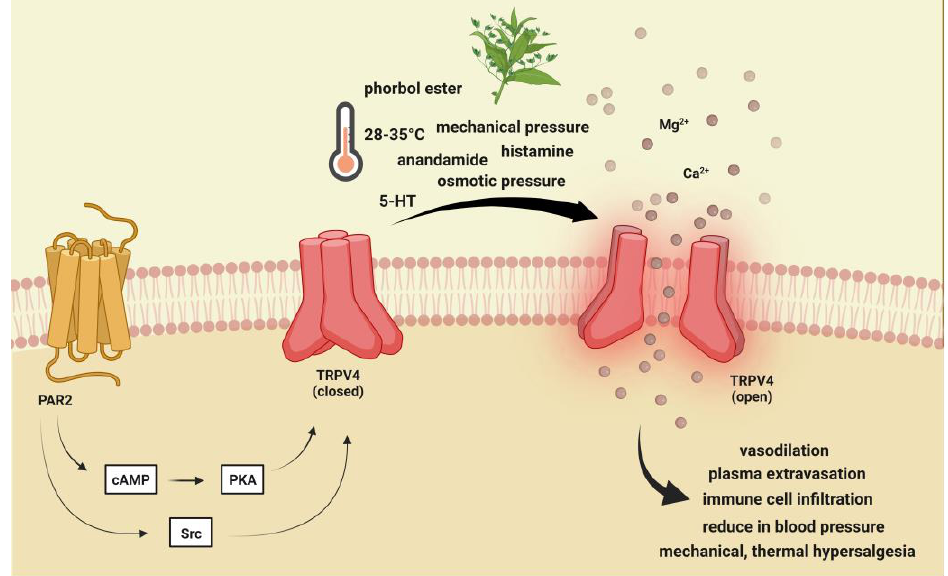
Figure 4. Transient receptor potential vanilloid 4 receptor activation. TRPV4 is activated by moderate heat (>24 °C to 27−35 °C), low pH, endocannabinoids, lipid metabolites, osmotic pressure, and phorbol ester and plant-derived compounds. PAR-2 activation may indirectly sensitize (via PKA, PKC, and PLC) TRPV4, thereby contributing to mechanical allodynia and thermal hyperalgesia. TRPV4: Transient receptor potential vanilloid 4, 5-HT: serotonin.